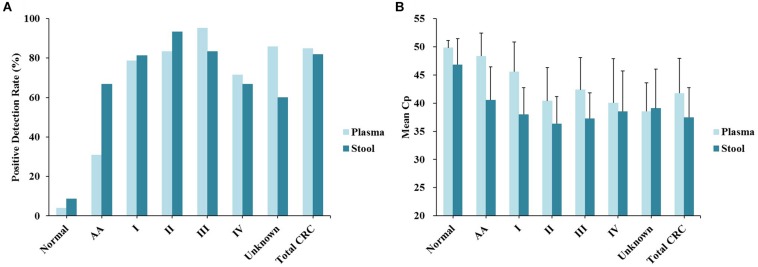
Sensitivity and specificity of plasma and stool methylated SEPT9 tests in detecting AA and CRC across stages I–IV. (A) Positive detection rates for normal individuals, AA and all stages of CRC. (B) The mean Cp values of methylated SEPT9 for normal individuals, AA and all stages of CRC.